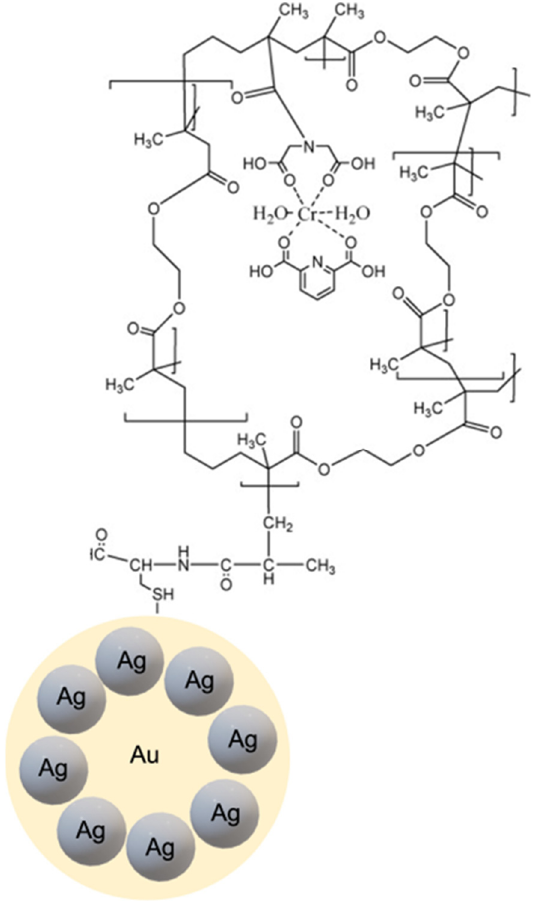
Figure 8. Representation of Au-Ag nanoclusters with shell based on DPA template imprinting. Reproduced with permission from [74].